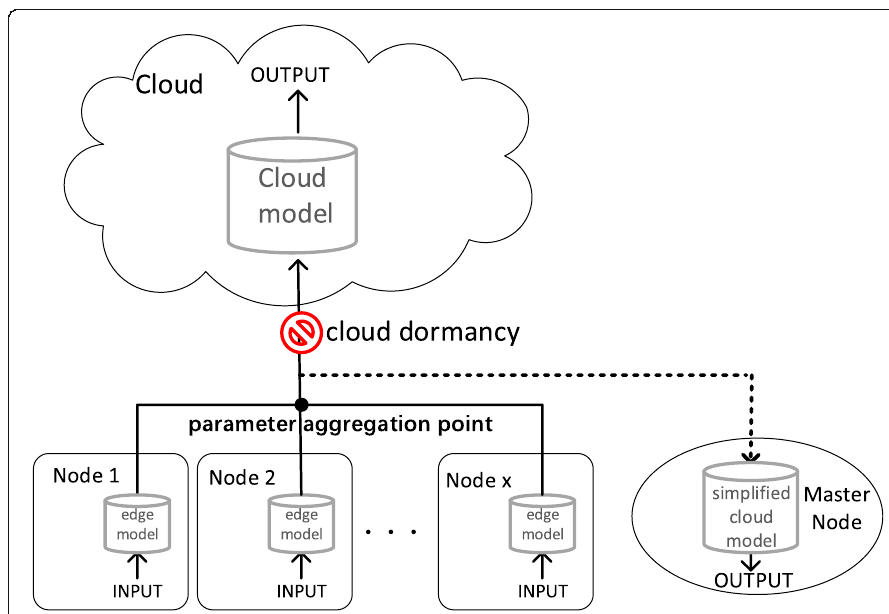
Fig. 4 Collaborative cloud-edge learning schematic. The cloud dormancy mechanism and the parameter aggregation scheme to optimize the task